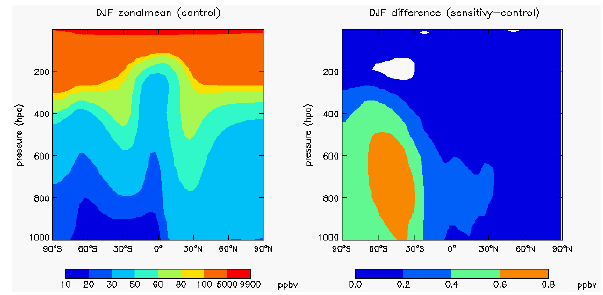
Fig. 2a. Changes in zonal mean O 3 concentration due to strato- spheric ozone recovery in